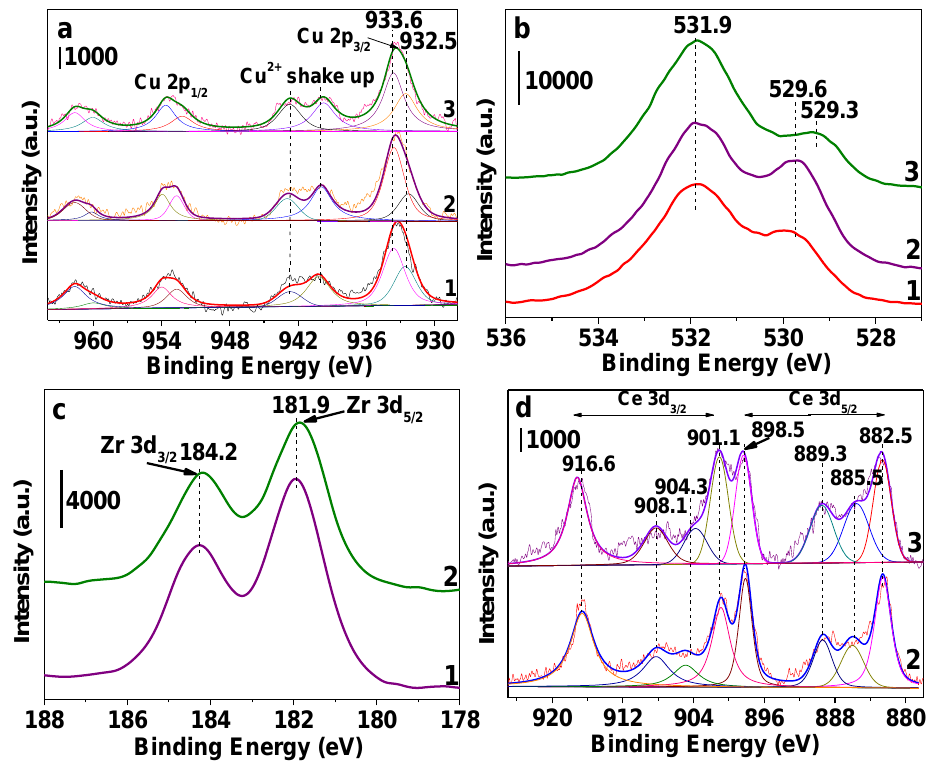
Figure 4. X-ray photoelectron spectra for ( a ) Cu 2p, ( b ) O 1s, ( c ) Zr 3d, and ( d ) Ce 3d over (1) CuZr 1 /ZSM-5, (2) CuCe 0.5 Zr 0.5 /ZSM-5 and (3) CuCe 1 /ZSM-5.